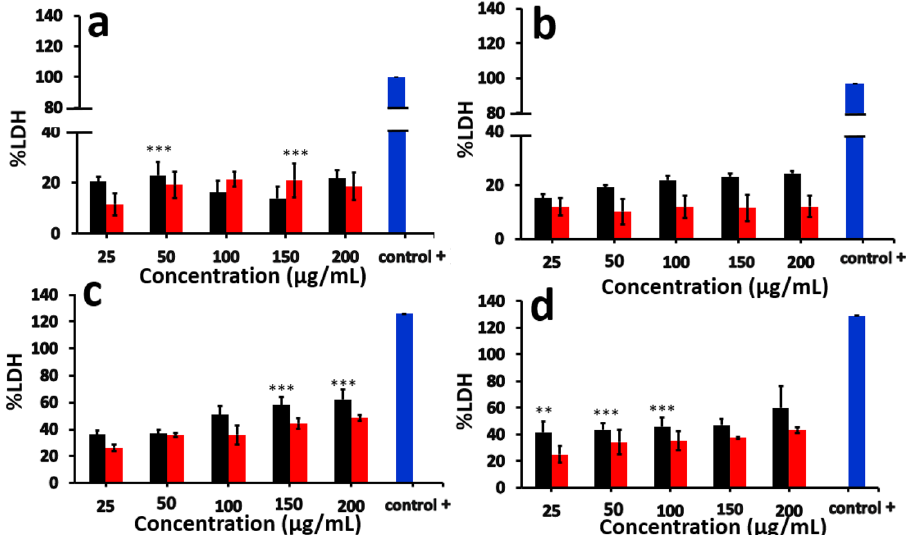
Figure 10. Concentration of LDH released into the medium after (a) 24 h, (b) 48 h, (c) 96 h, (d) 120 h, of incubation with PVC ( ■ ) and PMMA ( ) NPs. The data for 72 h incubation is given in the supporting information, Figure S10. The values represent as % LDH release with respect to control (untreated cells) and are the mean ± SEM of three experiments. Statistical analyses were done by one-way ANOVA (* p < 0.05, ** p < 0.01, *** p < 0.001, **** p < 0.0001) compared to control. Unexposed cell lysis solution was used as positive control to obtain the maximum LDH